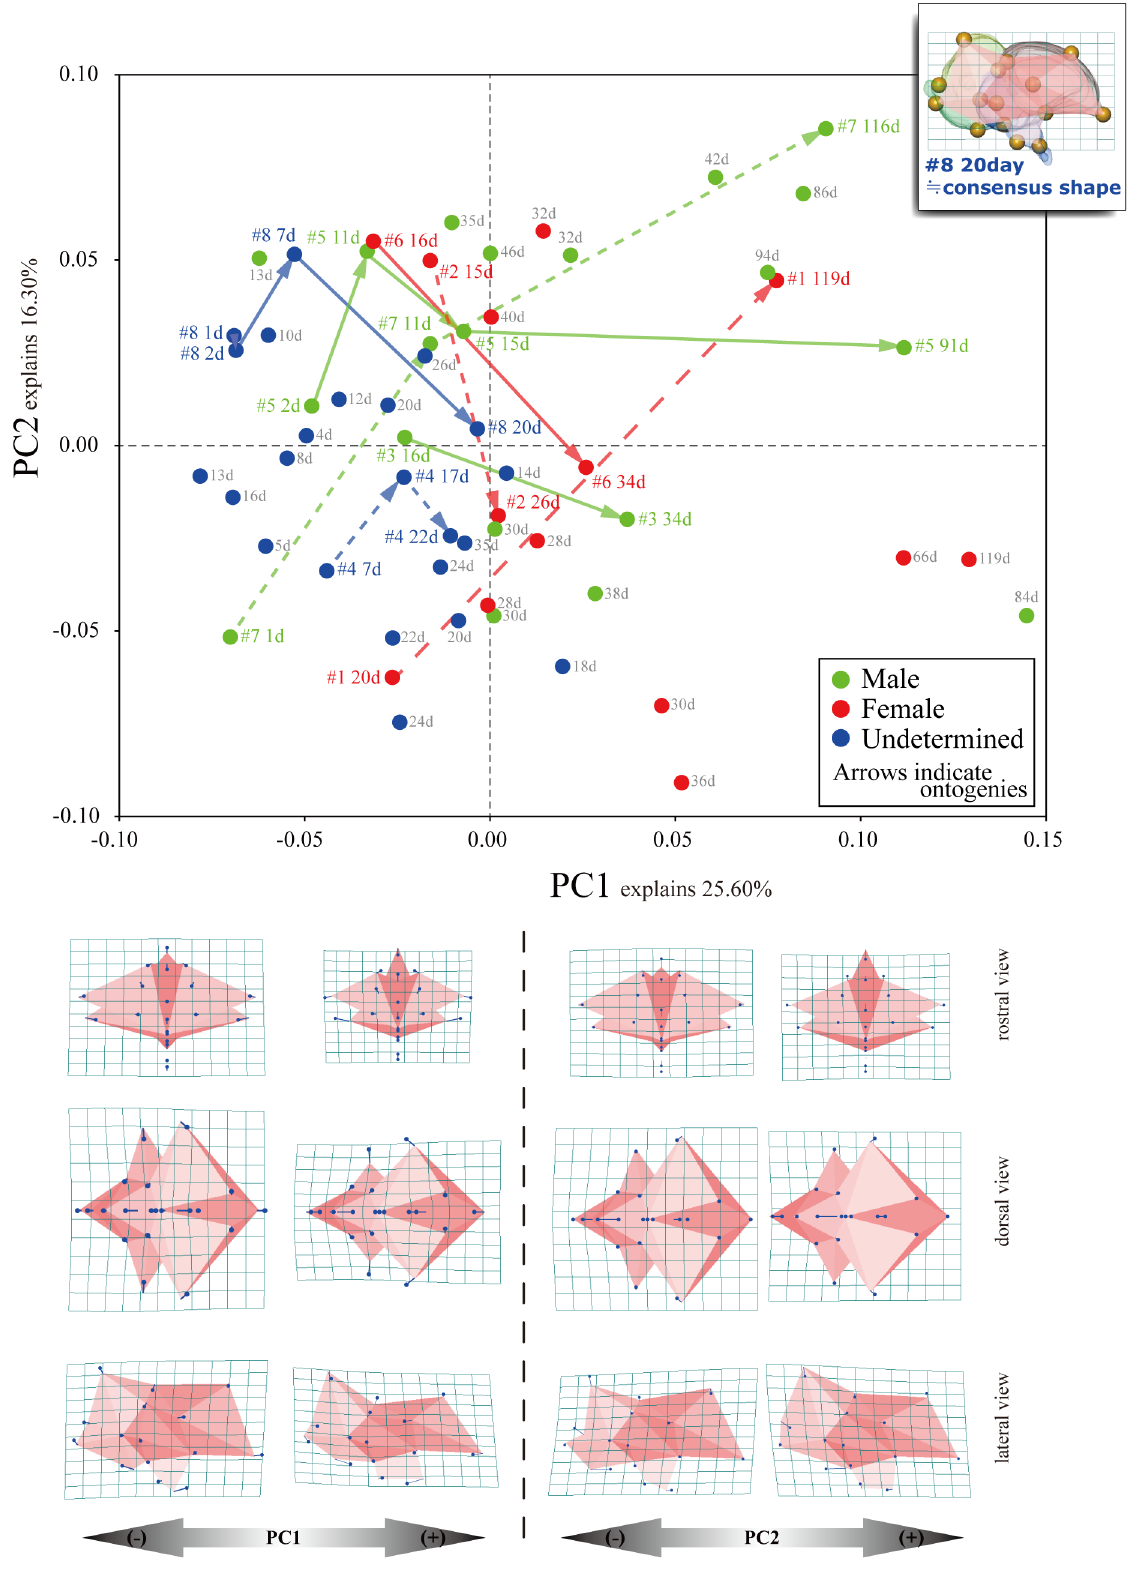
Fig 4. PCA and variation in brain shape for each principal component (PC) score. doi:10.1371/journal.pone.0133456.g002 PLOS ONE | DOI:10.1371/journal.pone.0133456 July 20,